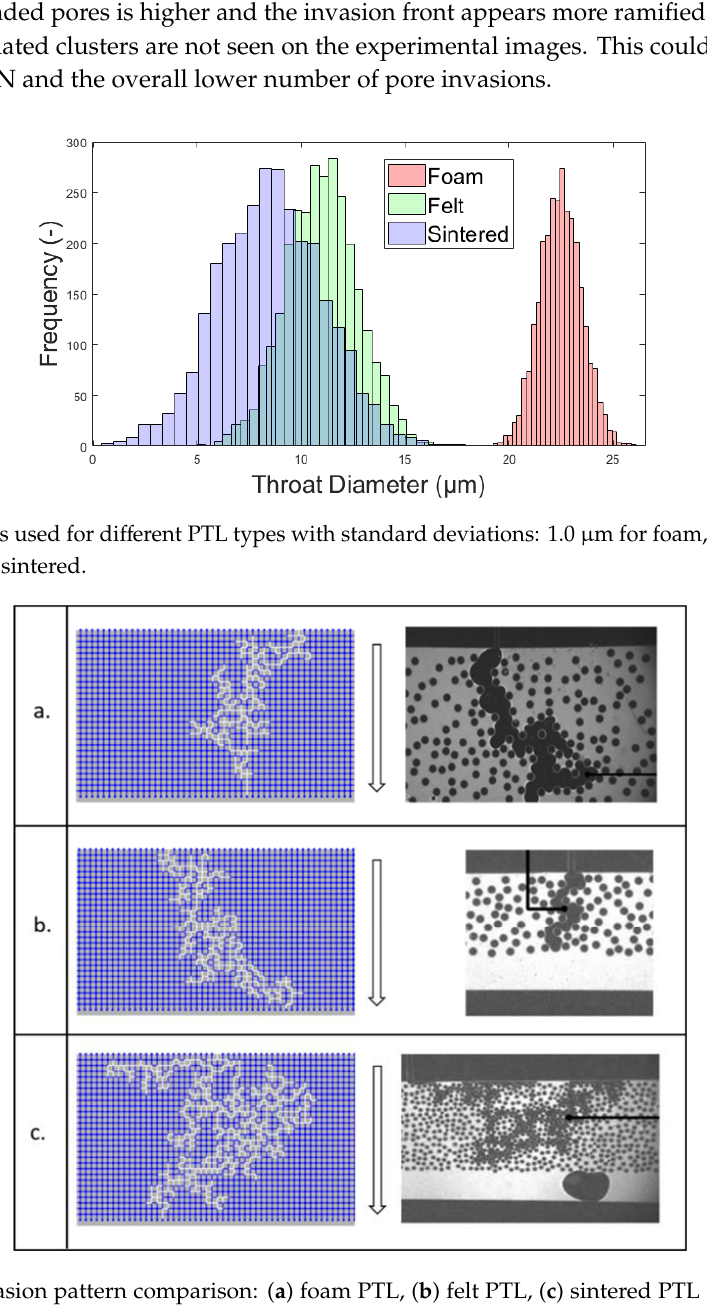
Figure 15. Invasion pattern comparison: ( a ) foam PTL, ( b ) felt PTL, ( c ) sintered PTL (Experimental images from [20] are reprinted with the permission from Elsevier,